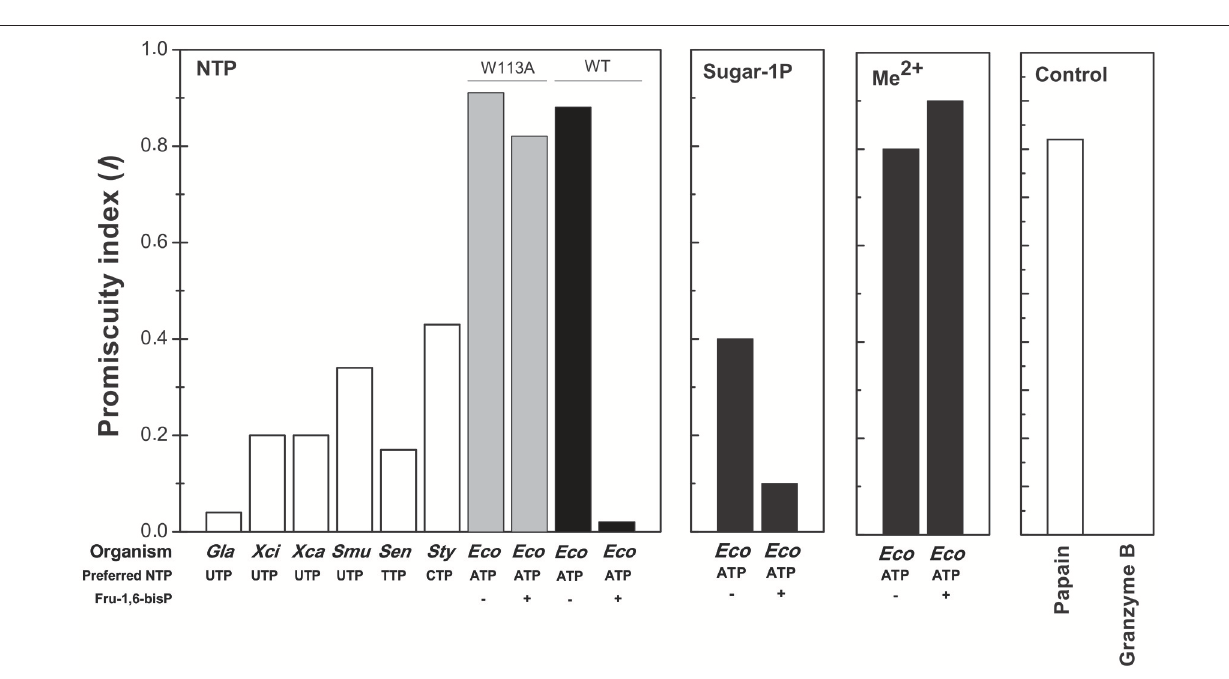
FIGURE 6 | Promiscuity indices ( I ) of different enzymes. I for the use of NTPs was calculated, as indicated in Materials and Methods, for TDP-Glc PPase from Salmonella enterica ( Sen ); UDP-Glc PPases from Xhantomonas campestri ( Xan ), X. citri ( Xci ), Streptococcus mutans ( Smu ) and Giardia lamblia ( Gla ); CDP-Glc PPase from S. typhi ( Sty ); ADP-Glc PPase from E. coli ( Eco , black bars) and the mutant E. coli ADP-Glc PPase W113A ( Eco, gray bars). For the use of different sugar-1P and divalent cations, I values were calculated for E. coli ADP-Glc PPase (black bars). I values of highly promiscuous papain and almost completely specific granzyme B were included as